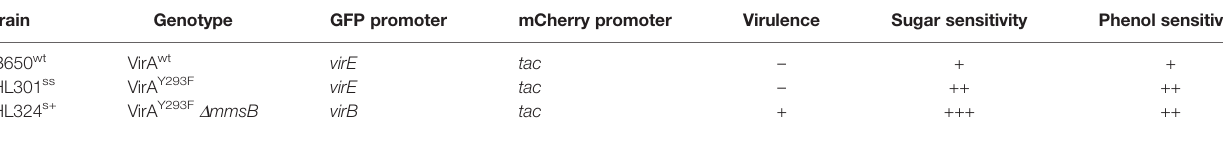
TABLE 2 | Characteristics of A. tumefaciens biosensor strains used in this study.